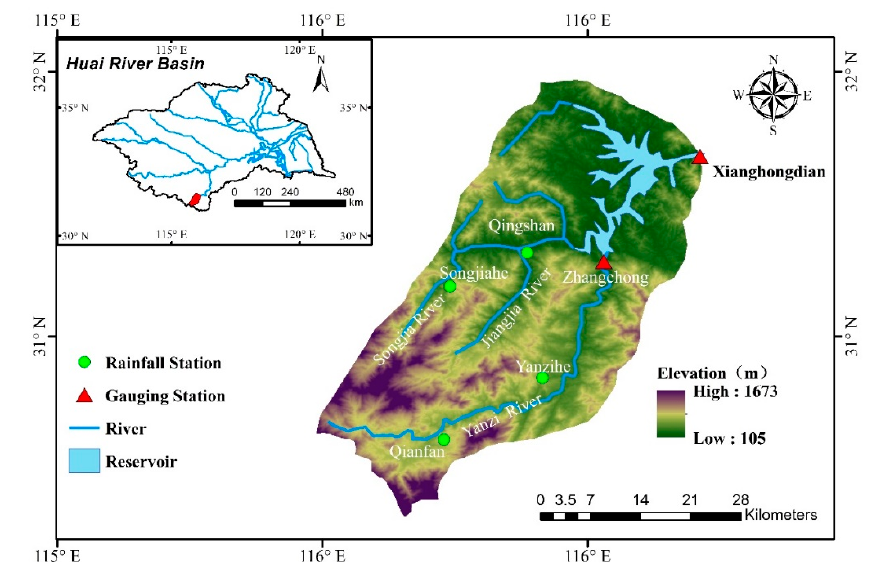
Figure 3. Xianghongdian Reservoir watershed. Table 1. Historical floods of Xianghongdian Reservoir.